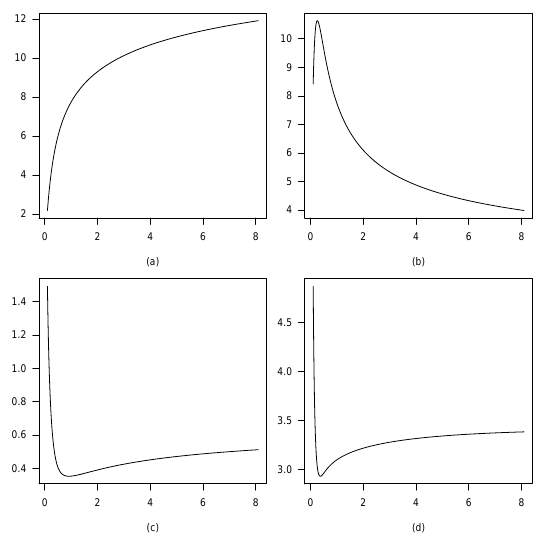
Figure 6 – Mean, in panel (a), variance, in panel (b), skewness, in panel (c), kurtosis, in panel (d), ( θ , α ) } , for θ = 7.75 and α > of the power Poisson distributions { r i